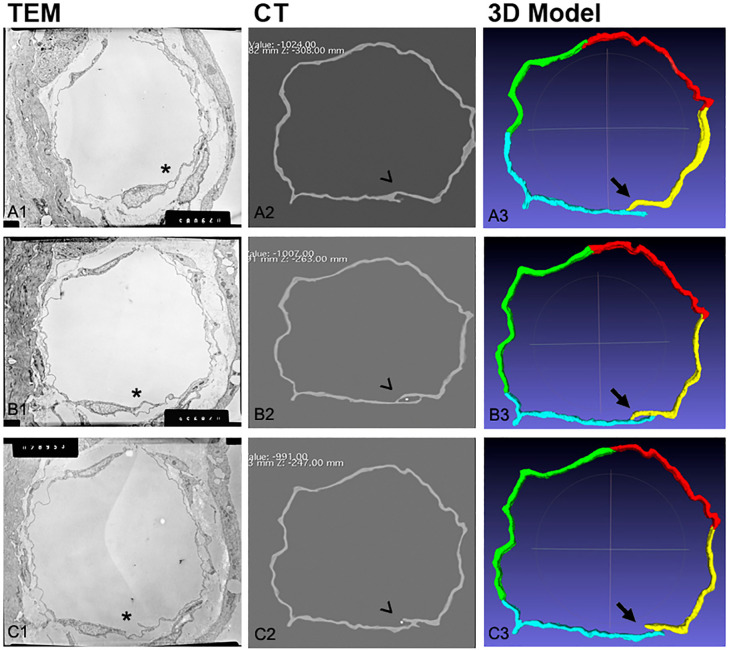
Representative serial sequence combined representation of TEM micrograph–CT scanning–3D digital model at different levels.(A1 to A3; B1 to B3; C1 to C3). In the TEM-CT-3D digital model sequence, from top to bottom and from left to right, three emblematic phases of the intraendothelial channel formation are presented. A1 to A3: cytoplasmic evagination (finger-like) opening towards the extravasal space; B1 to B3: channel closed with the TCi (white dot) in the lumen; C1 to C3: channel opening towards the lumen and TCi in the lumen. TEM: transmission electron microscopy; CT: computed tomography; TCi: invasive tumor cell. The three symbols (*), (^), (↑) indicate the abovementioned main ETC phases shown using the three different techniques.